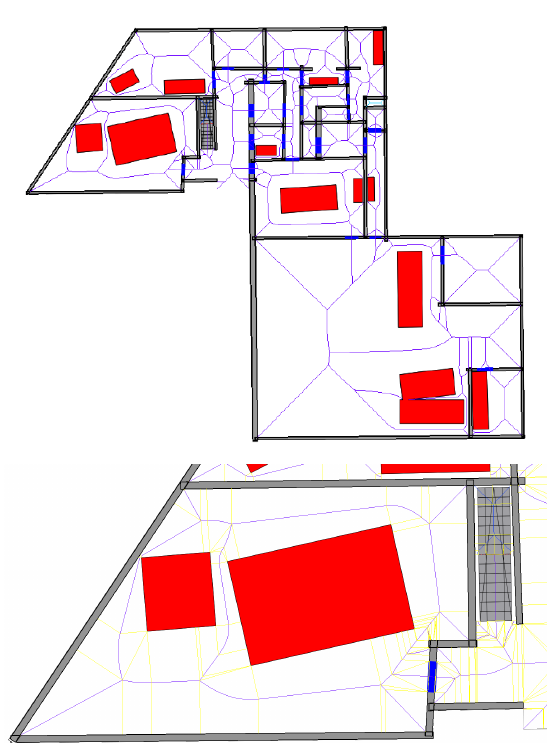
Figure 5: (a) The simulation sandbox. (b) A close-up that shows the medial axes (lines in blue) and the explicit corridor mesh that utilizes the equidistant lines to obstacles (in yellow).